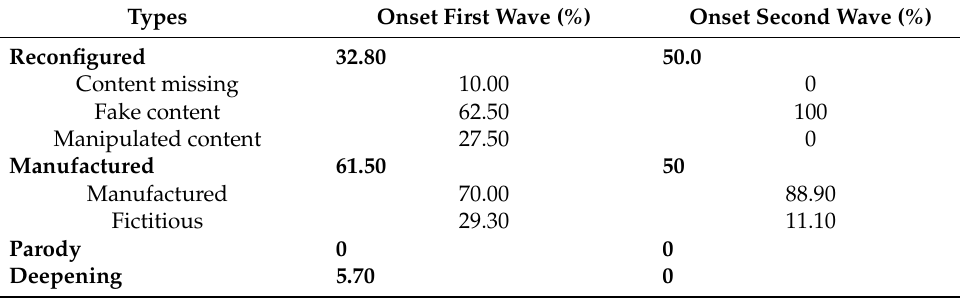
Table 2. Typologies of hoaxes in the two stages of analysis.